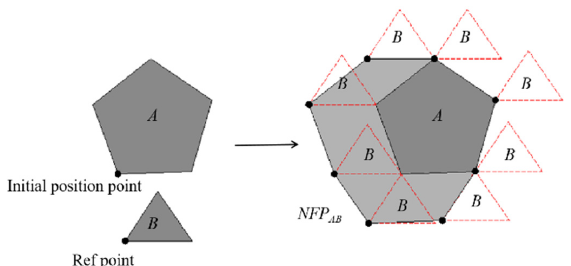
Figure 1. The no-fit polygon NFP AB of two convex polygons, A and B.